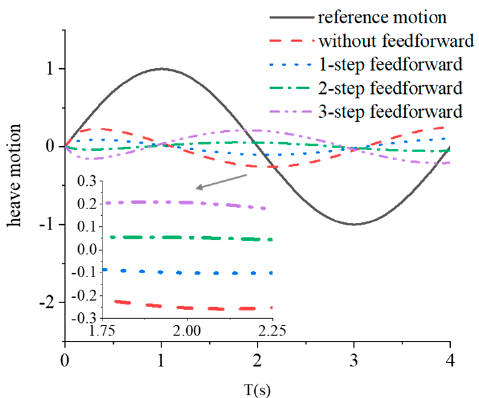
Figure 6. Heave motion of the payload of a sinusoidal signal based on actual-data feedforward con-